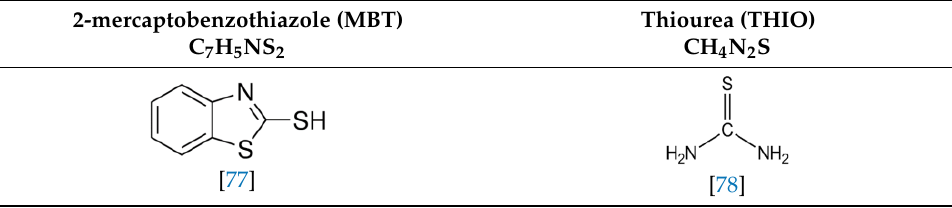
Table 6. Structure of sulfur extractants.